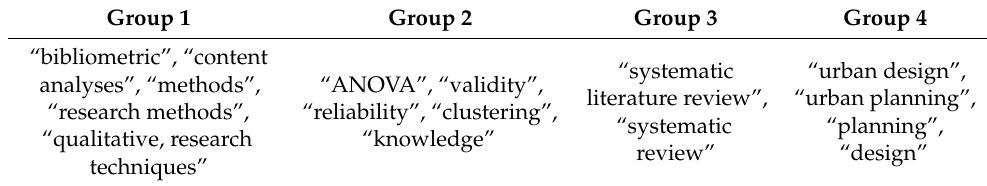
Table 1. The keywords for searching on the relevant books and book chapters.